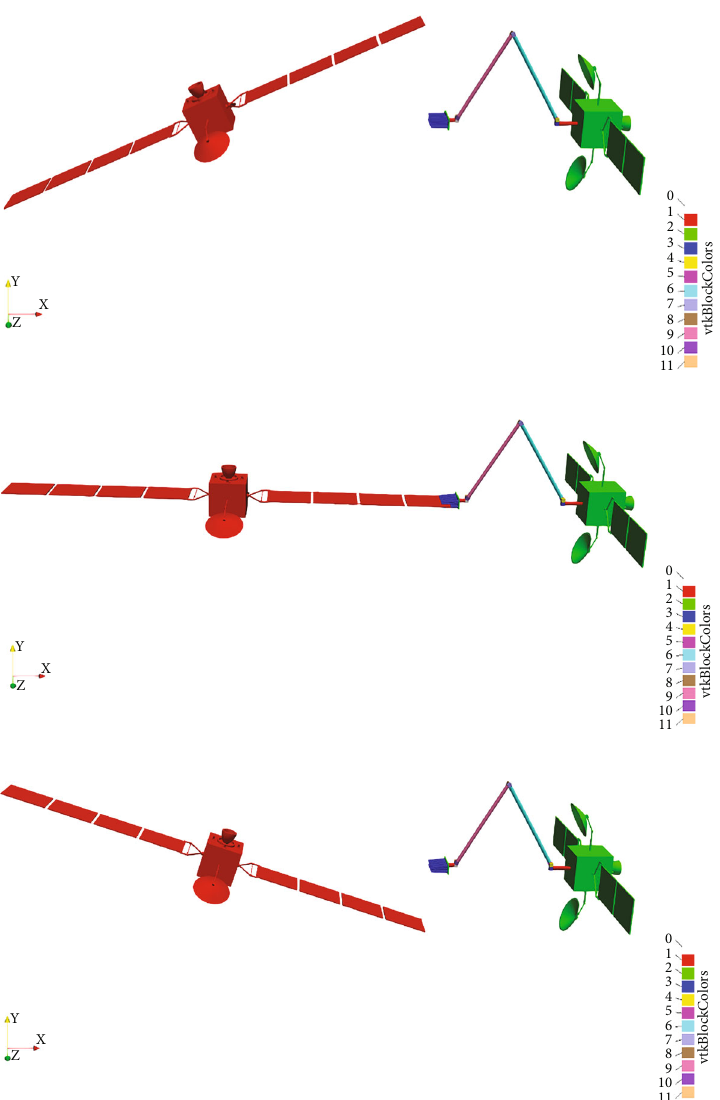
Figure 2: Spin satellite derotation e ff